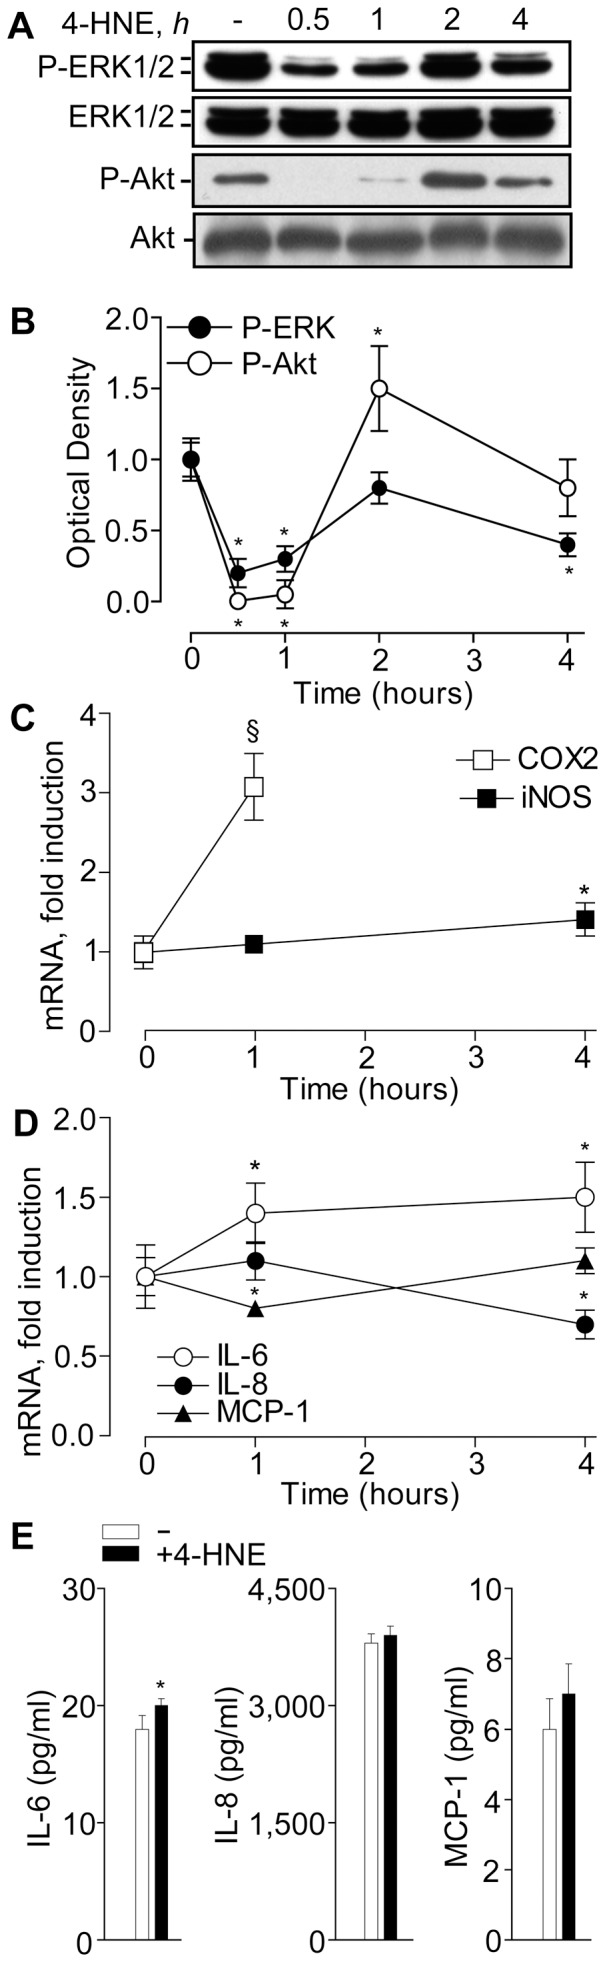
4-hydroxy-2-nonenal (HNE) effects on signal transduction and expression of pro-inflammatory mediators in NHEK.Time-dependent effects of 25 µM HNE on ERK1/2 and Akt1 phosphorylation: A. Western blot and B. Densitometry of total cell extracts. Dynamics of HNE effects on COX-2 and iNOS (C) and pro-inflammatory cytokine (D) gene expression. Cytokine levels in the culture medium after 24 h treatment with 25 µM HNE (E). *P<0.05 and §P<0.01 versus untreated controls.